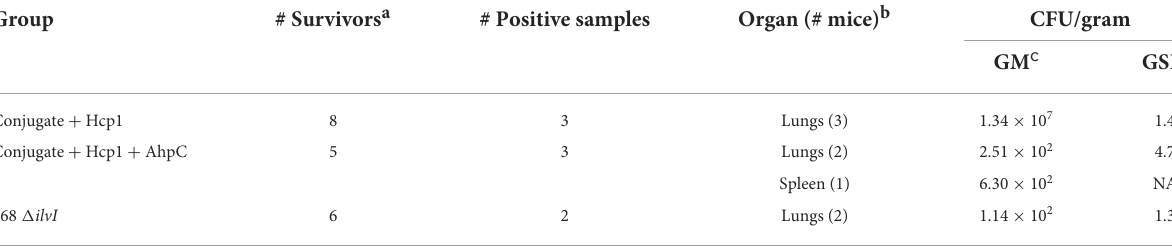
a n = 10mice/groupbeforechallenge.Thedatawerefromsurvivorsonday60afterchallenge. b